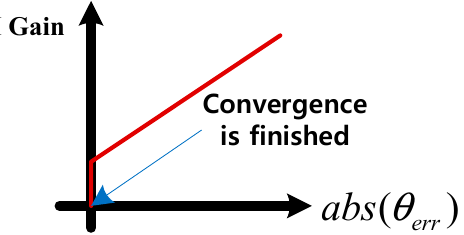
Figure 7. Variable I controller gain adaption according to the position error.